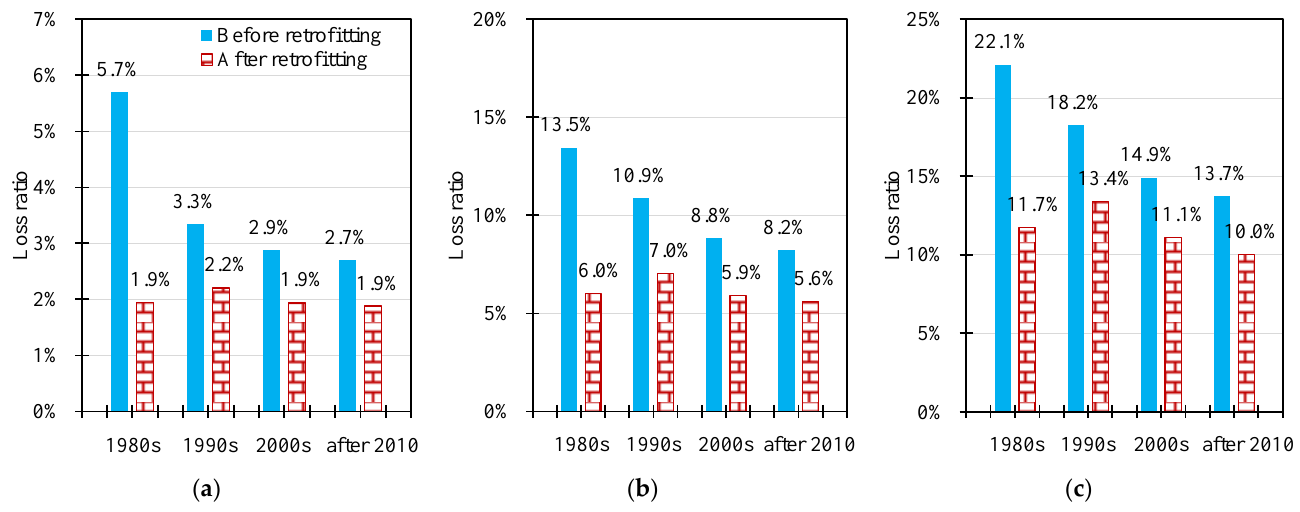
Figure 12. Seismic loss ratios of buildings with different construction years. ( a ) SLE; ( b ) DBE; ( c ) MCE.